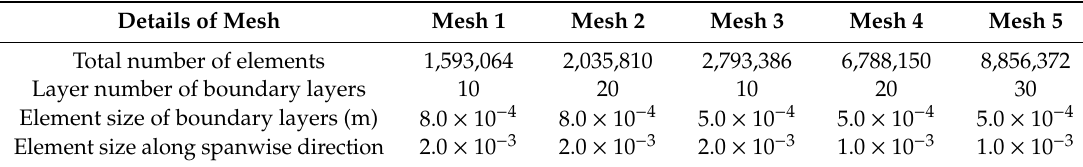
Table 1. Mesh details of the selected meshing schemes for mesh independence study.